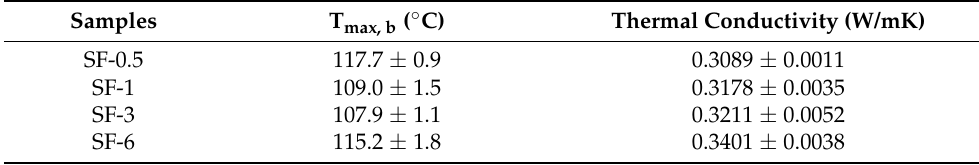
Table 3. The maximum back-face temperature and thermal conductivity of the composites.